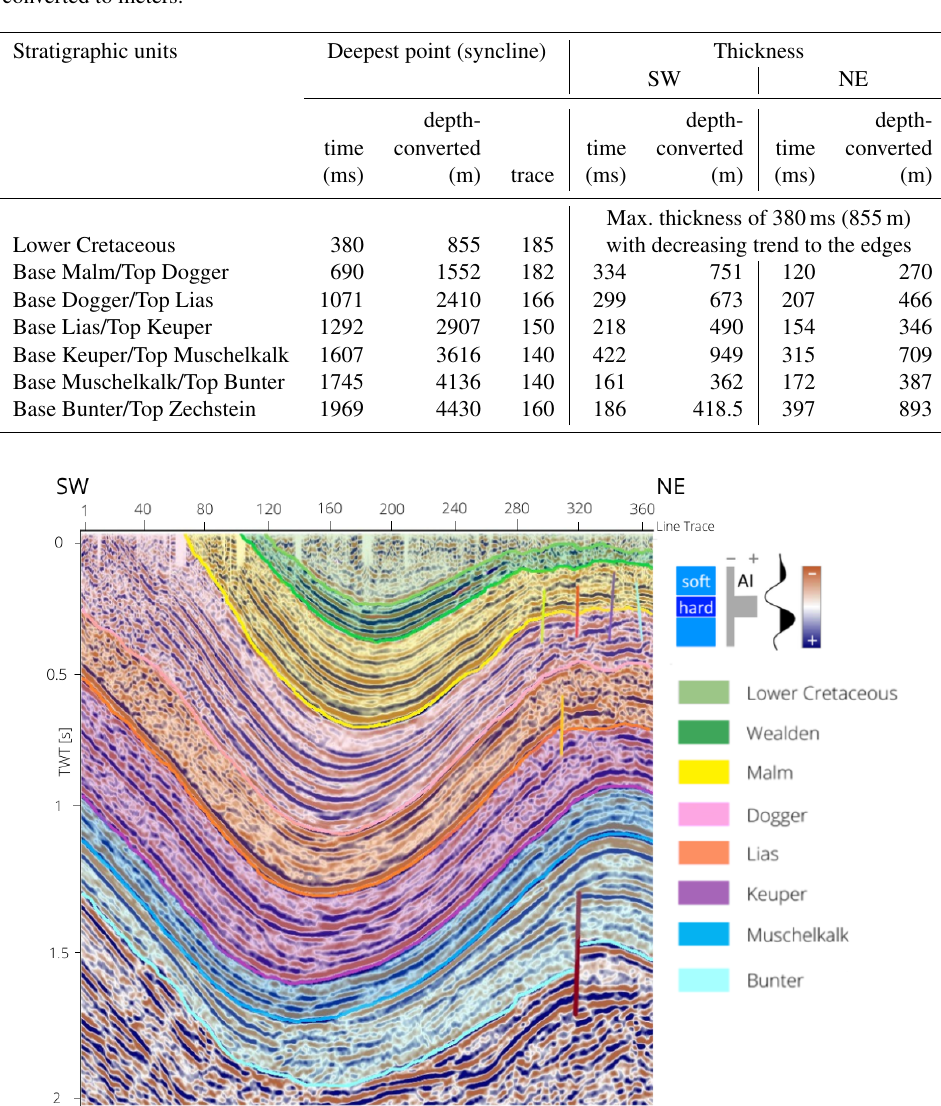
Figure 6. Interpreted seismic section RHBGOSTO U940999 displaying the Mesozoic stratigraphic units of the Weser-Wiehengebirge- Syncline (SW) and adjacent Quetzen Anticline